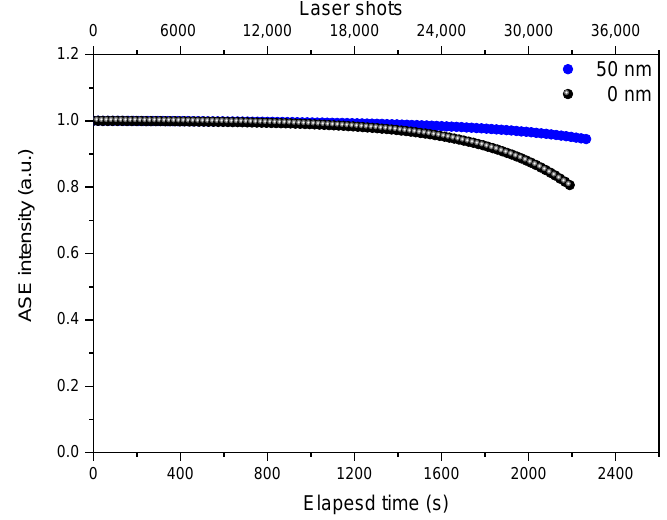
Figure 8. ASE operational stability behavior for TiO 2 CL thicknesses of 0 and 50 nm